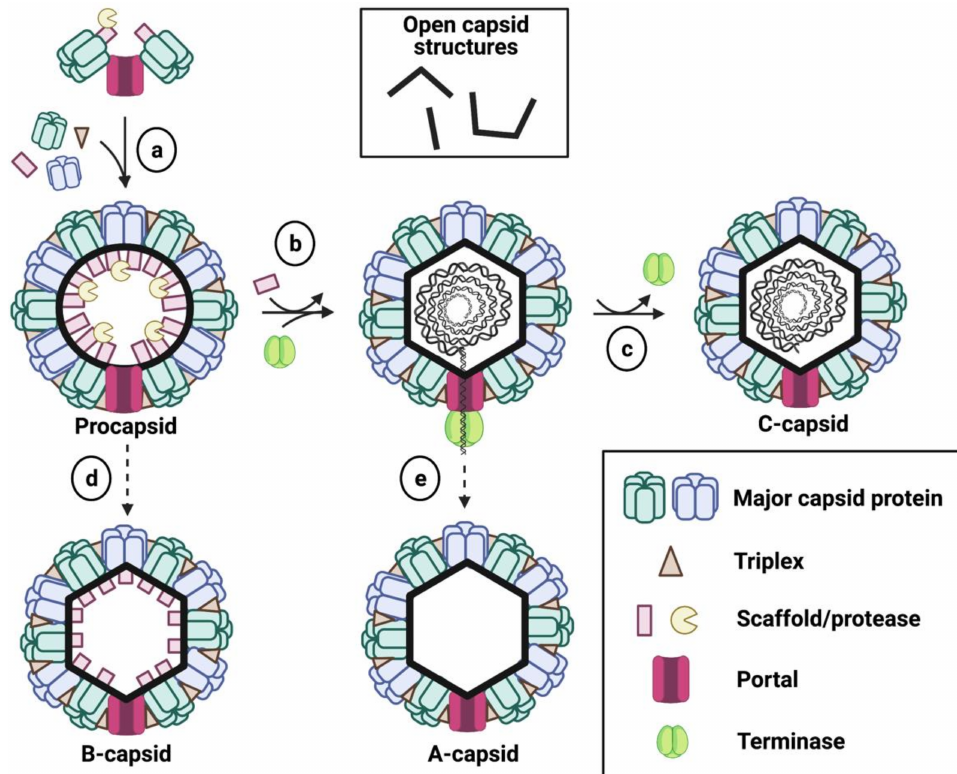
Figure 2. Herpesvirus capsid assembly pathway. (a) Capsid assembly is thought to be nucleated by the portal complex that interacts with the MCP, triplexes, or scaffold. The MCP and triplexes assemble around the scaffold into a spherical procapsid. (b) The terminase complex binds to the portal and the protease cleaves the scaffold. The capsid is angularized, the scaffold is extruded, and the DNA genome is packaged into the capsid. (c) The DNA is then cleaved and the terminase is released, resulting in the formation of a mature C-capsid. B-capsids (d) and A-capsids (e) are thought to be the by-products of assembly. B-capsids form whenever the scaffold fails to be released from the capsid whereas A-capsids form if the scaffold is released but the DNA does not get packaged. The top inset illustrates the open capsid structures observed in some of the capsid assembly experiments described in the text. For clarity, the SCP and auxiliary proteins are not shown. The figure was created with BioRender.com, accessed on 10 July–19 September